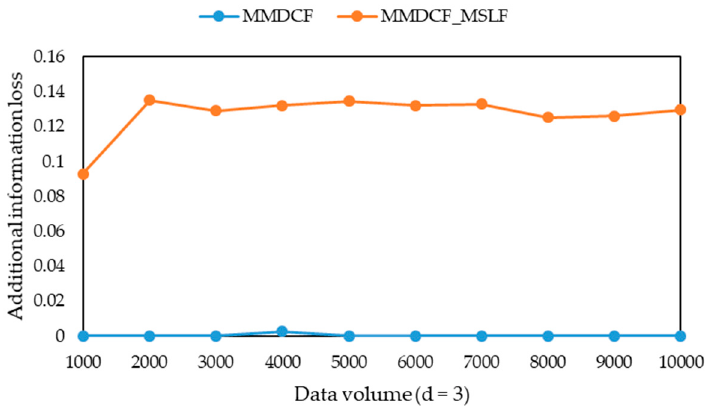
Information 2019 , 10 , x FOR PEER REVIEW